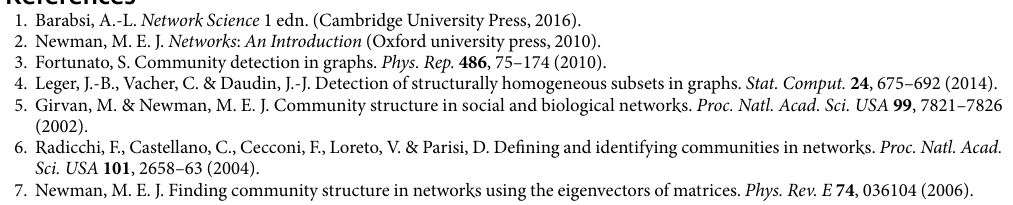
the information of the unobserved edge when there are loops in the network. Because we consider the sparse network, which is locally tree-like, the effect of the loops is typically negligible. Second, the update equations (20) and (21) of the parameters in the maximisation step of the EM algorithm contain the unobserved edge. However, because we consider the LOOCV in which only a single vertex pair is unobserved, this discrepancy results in a difference of only O ( N − 1 ) to the parameter estimation. Therefore, our analytical results in terms of BP are suffi- ciently accurate to serve as error estimates when using the LOOCV.